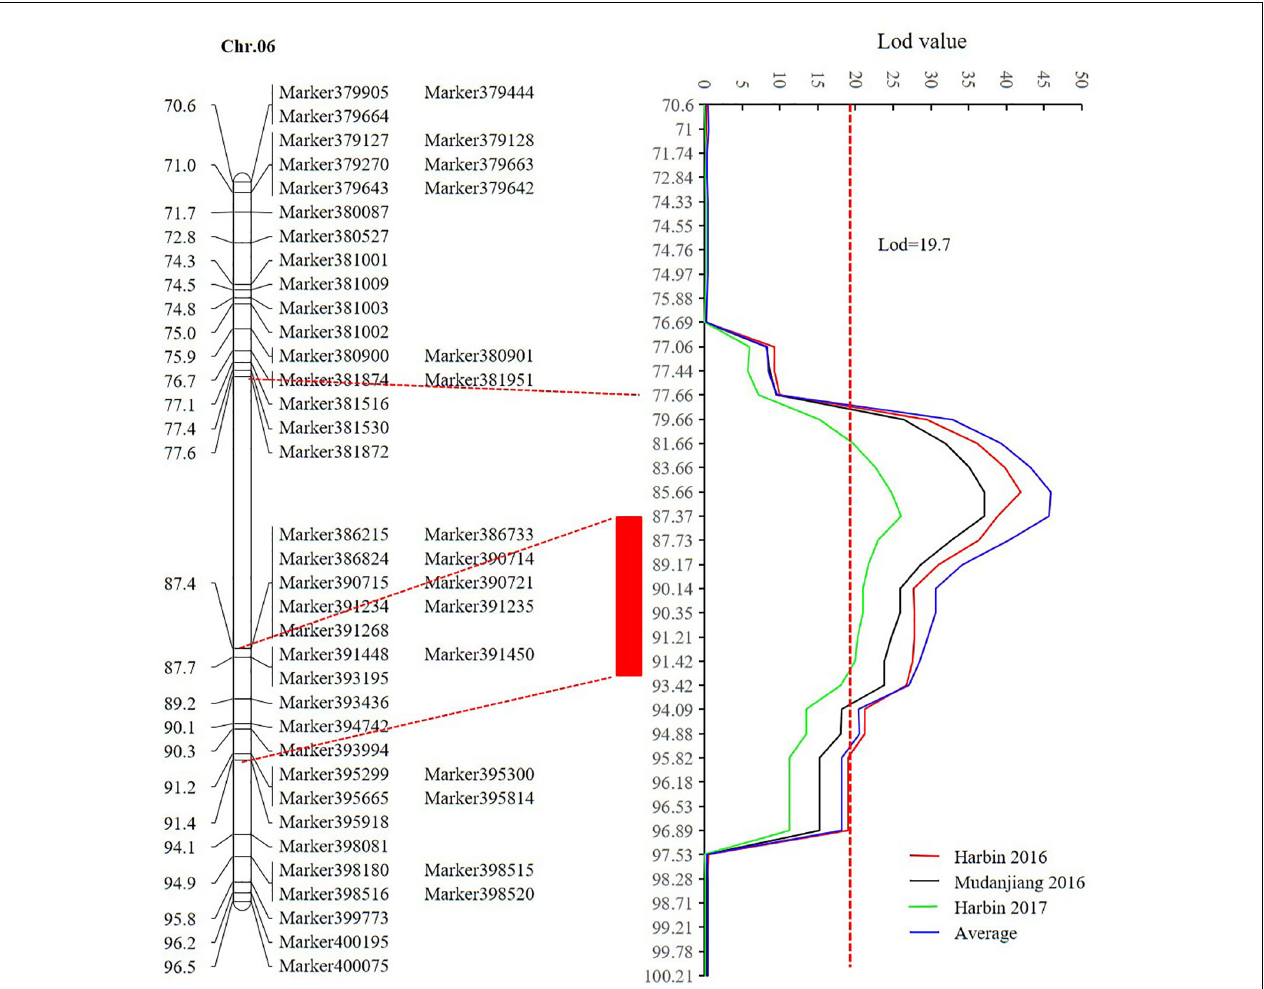
FIGURE 7 | The high confidence interval of QTL detected on chromosome 6 (CIM method). Within the genetic interval from 77.66 cM to 87.4 cM between markers Marker381872 and 386215 with physical positions 15,741,239–28,154,637, no recombination was found according to the sequencing result. The red rectangle represents the high confidence interval between markers Marker386215 and 395918 with physical positions from 28,154,637 to 42,126,497.